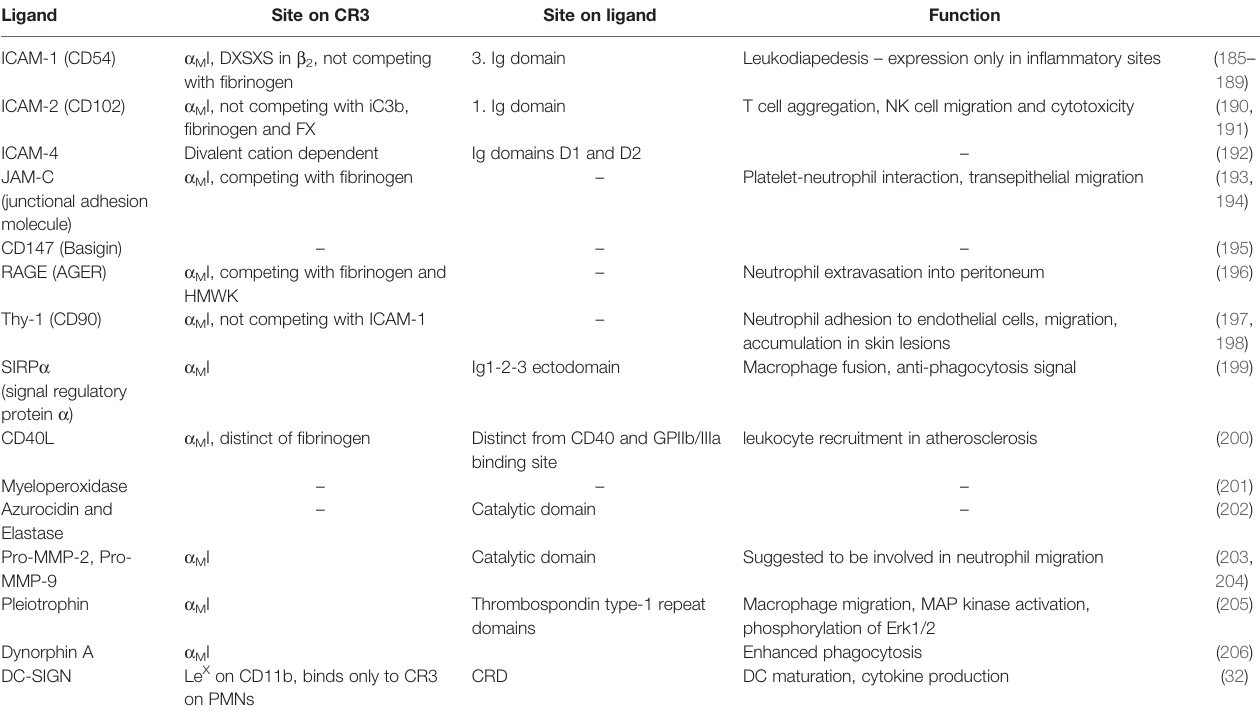
TABLE 5 | Leukocyte adhesion and